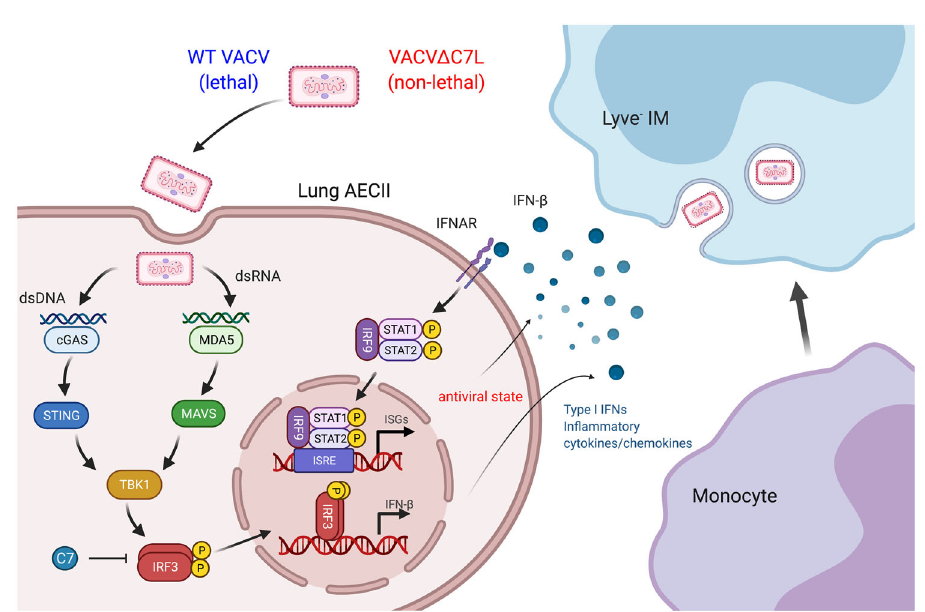
Fig. 7 Model of lung innate immune system to protect against vaccinia virus pulmonary infection. Vaccinia C7L encodes a virulence factor. Whereas intranasal infection of WT VACV causes lethality in mice, VACV Δ C7L infection is non-lethal. Here we show that C7 blocks the phosphorylation of transcription factor IRF3, which is critical for the induction of IFNB gene expression. VACV Δ C7L infects lung AECIIs and triggers IFN- β production via activating the cytosolic DNA and dsRNA-sensing pathways that are dependent on MDA5 and STING. IFN- β -IFNAR signaling on lung AECII further strengthens antiviral effects via the induction of IFN-stimulated genes. Under the in fl uence of various cytokines and chemokines produced by lung